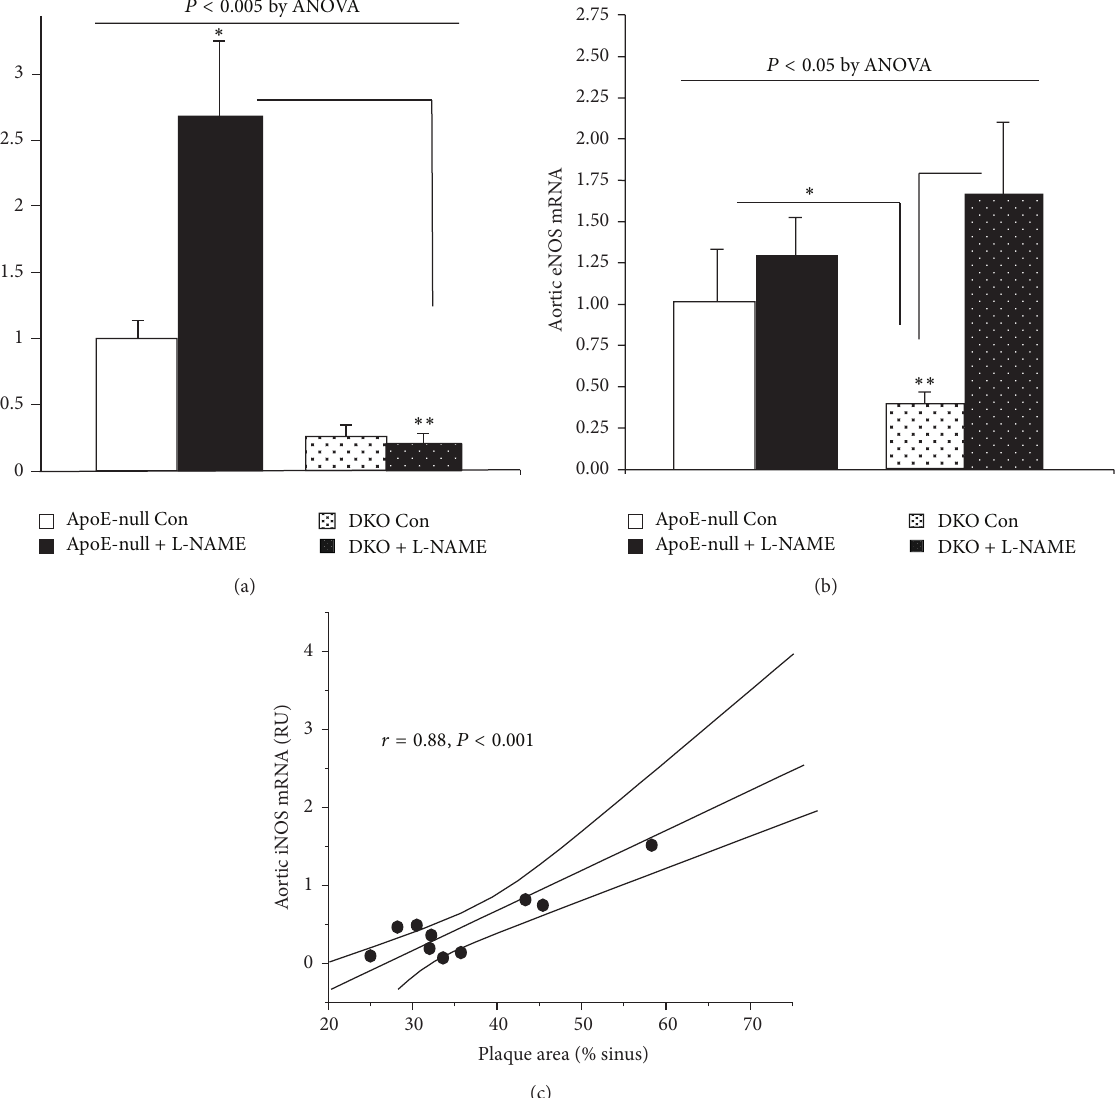
Figure 4: Aortic iNOS is induced by L-NAME in ApoE-null mice and correlates with atherosclerosis. Effects are expressed relative to the control ApoE-null mice. (a) iNOS expression by real-time PCR indicates a 4-fold excess in control ApoE-null versus DKO ( ∗ 𝑃 < 0.05 ) and a tenfold difference after L-NAME ( ∗∗ 𝑃 < 0.01 ), number of mice used in the experiment: 9 apoE-null control: 7 apoE-null L-NAME, 8 DKO control, and 8 DKO L-NAME. (b) eNOS is significantly increased by L-NAME in the DKO but not in the ApoE-null mice, 𝑛 = 5 animals in each group. (c) Significant positive correlation between the extent of the plaque and iNOS